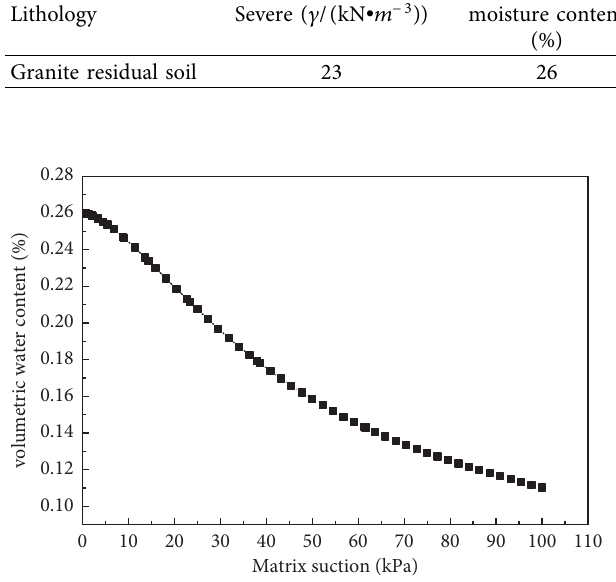
Figure 3: Variation curve of the volumetric water content with matric suction.